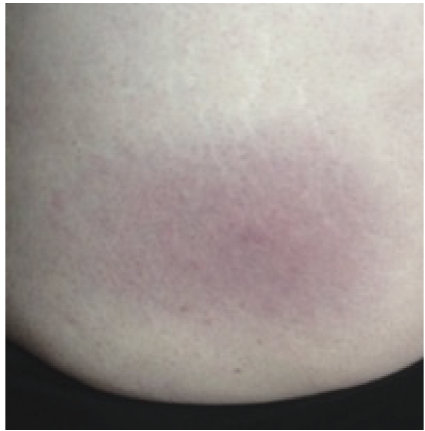
Figure 1: The patient noted an oval nonpainful red skin lesion on her left hip which was attributed to a drug